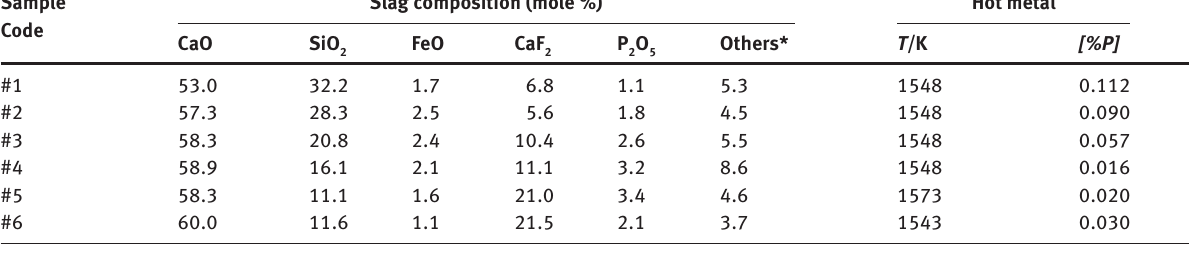
Table 3: Industrial slags of hot metal processing and corresponding hot metal temperature and phosphorus level.